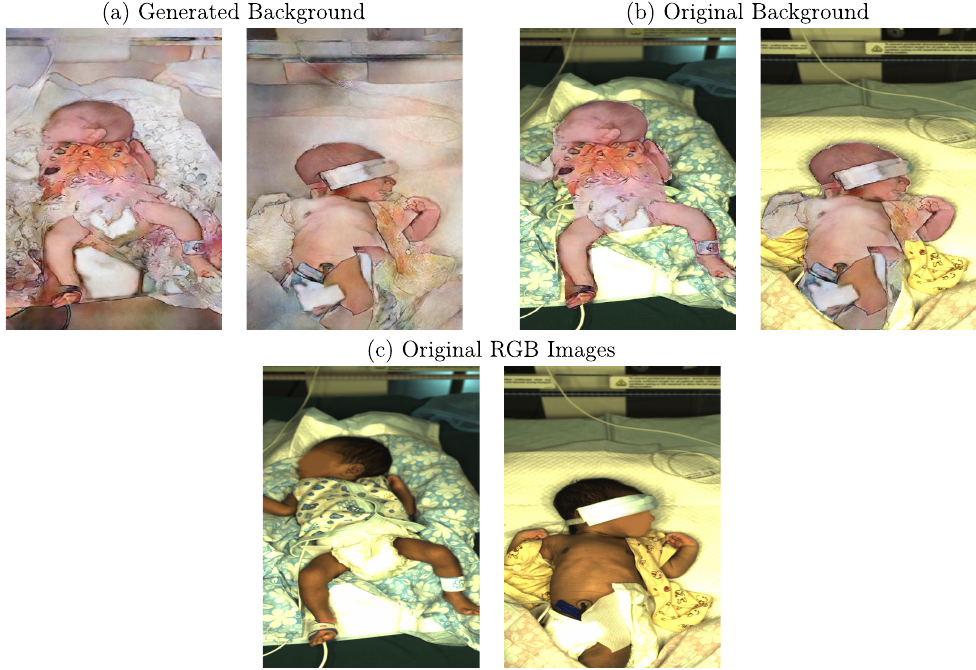
Figure 5. Examples for generated images with ( a ) generated and ( b ) original background and ( c ) original RGB images from the clinical dataset.